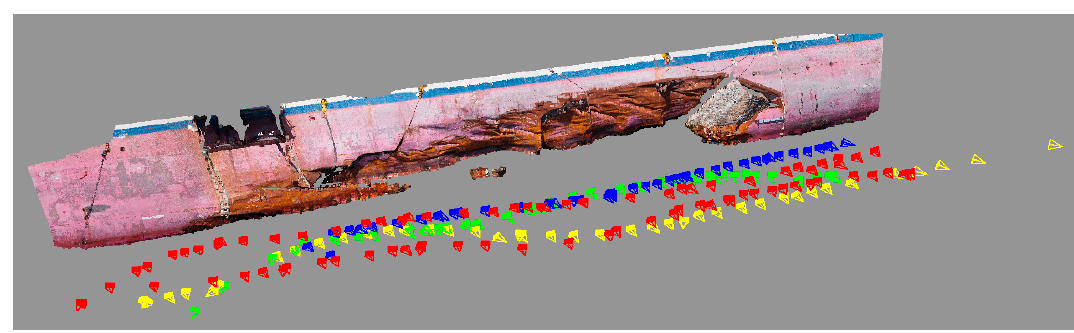
Figure 8. Camera network of the complete above-the-water survey made up of four different acquisitions.